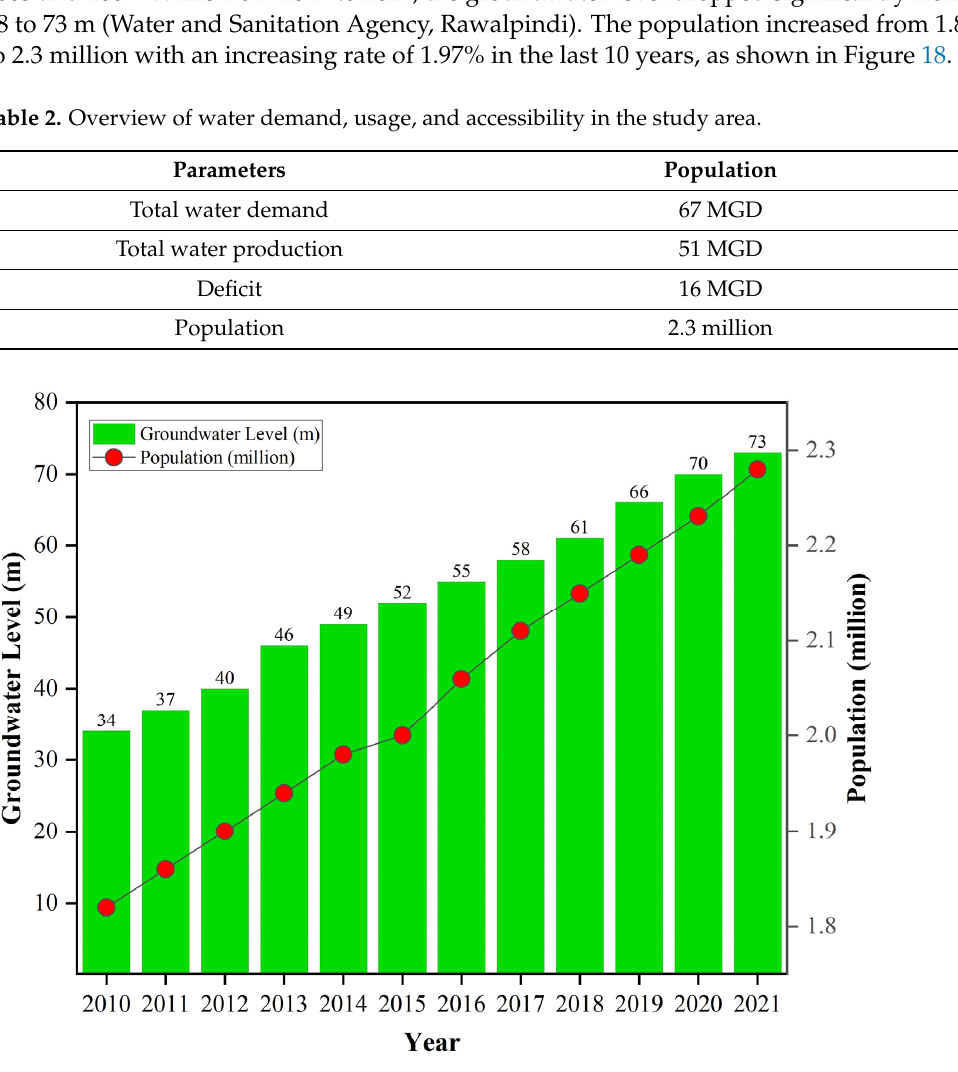
Figure 18. Changes in groundwater level with the rise in population overtime.